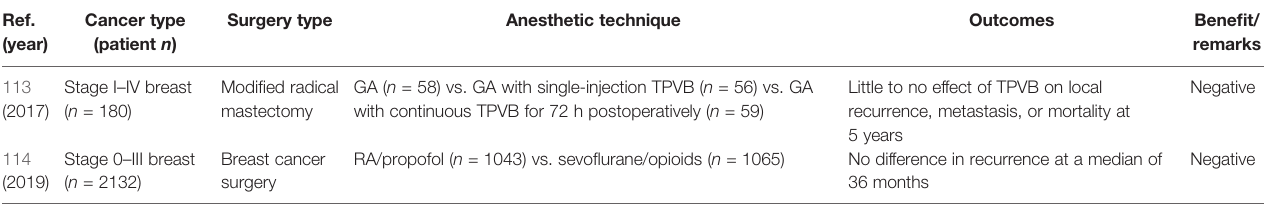
TABLE 3 | Prospective randomized trials on anesthetic technique and breast cancer recurrence. Ref. (year)